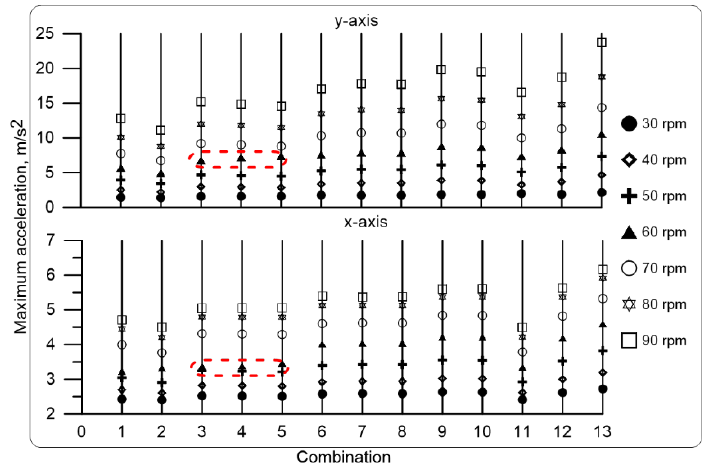
Figure 8. Maximum acceleration of gripper for different length combinations and operating speeds.